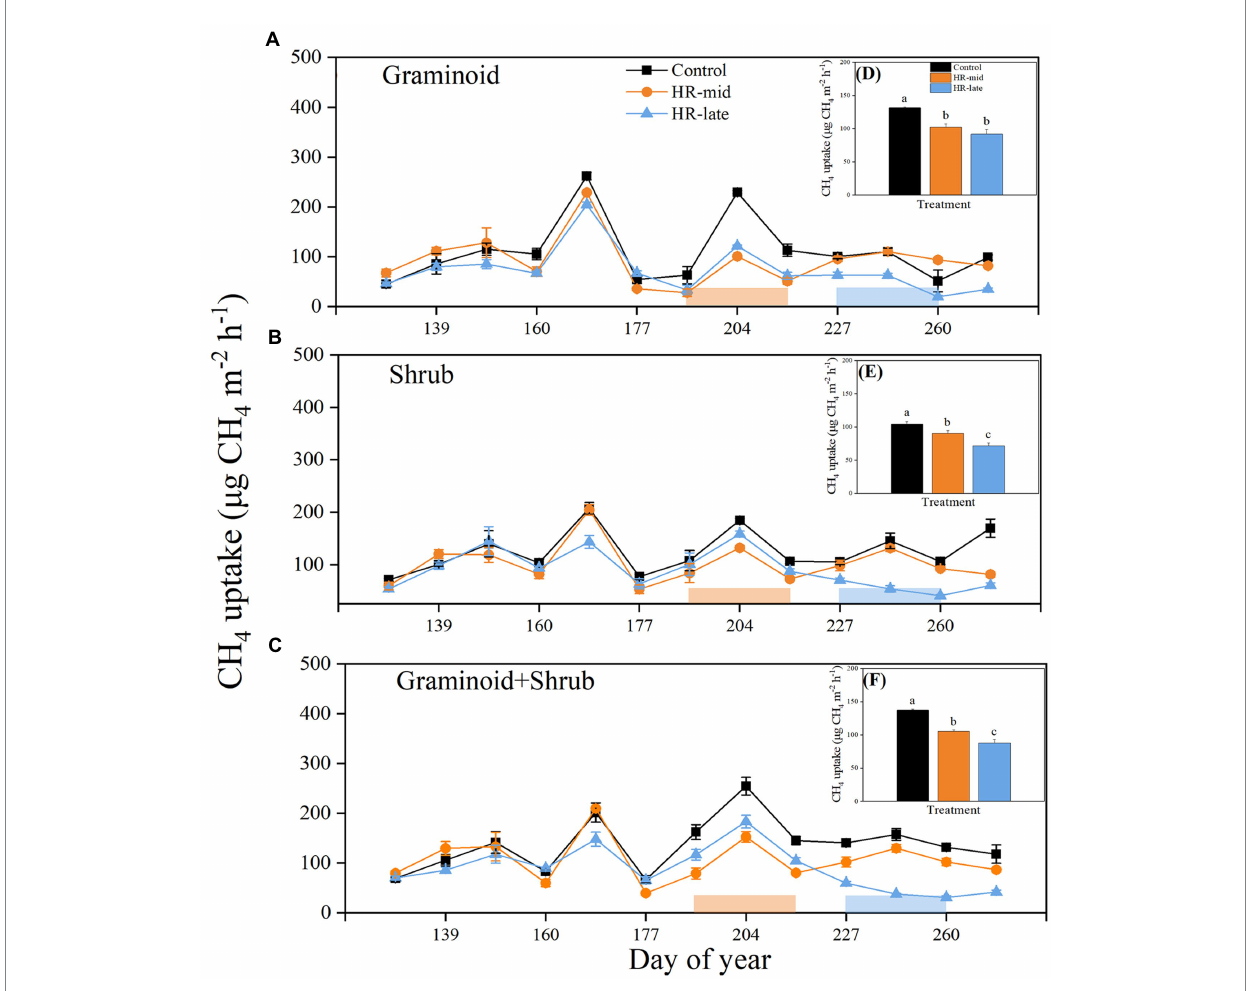
FIGURE 2 Seasonal dynamic and mean of CH 4 uptake under heavy rainfall treatments in graminoid (A,D) , shrub (B,E) , and graminoid +shrub (C,F) plots. Different letters above bars in d, e and f indicate significant difference among treatments at p ≤ 0.05. The orange and blue shaded regions in a–c indicate the periods of the HR-mid (heavy rain imposed in middle of the growing season, orange line) and HR-late (heavy rainfall imposed late in the growing season, blue line) treatments, respectively. Error bars show one standard error of the